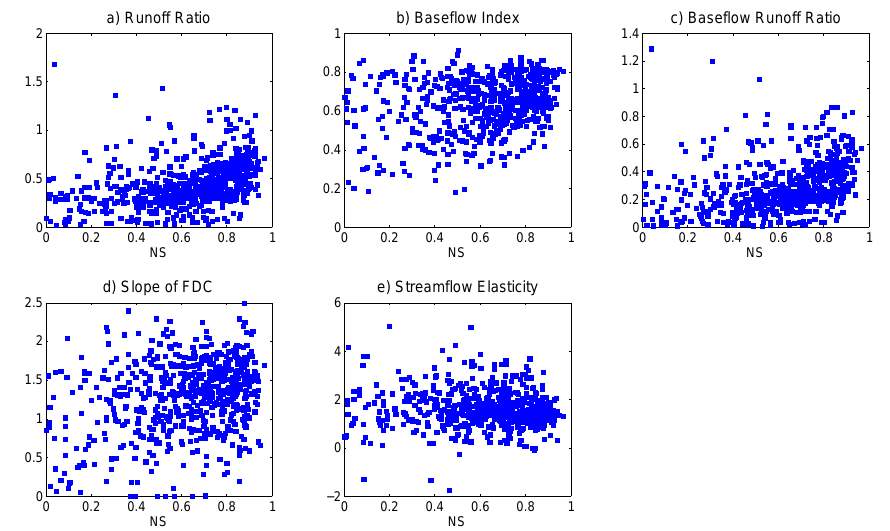
Fig. 8. Relationship between Nash Sutcliffe efficiency (NS) and (a) runoff ratio, (b) baseflow index, (c) baseflow runoff ratio, (d) slope of FDC, and (e) streamflow